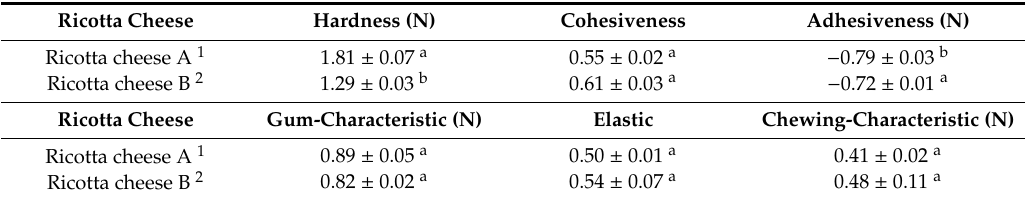
Table 6. Texture profiles of ricotta cheeses made with cheese whey / full-fat or skimmed goat milk (replicated for three di ff erent samples).